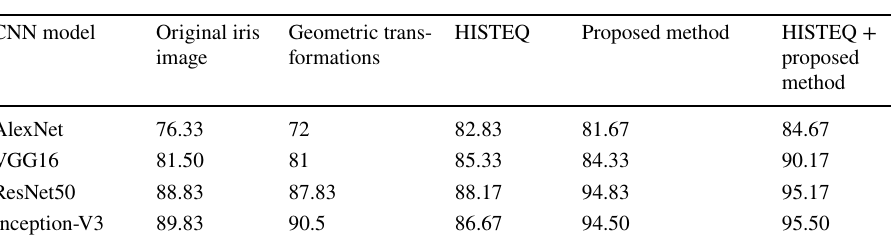
Fig. 7 ROC curve classified by two cases: a case 1, b case Table 2 Accuracy of classification experiment(%)